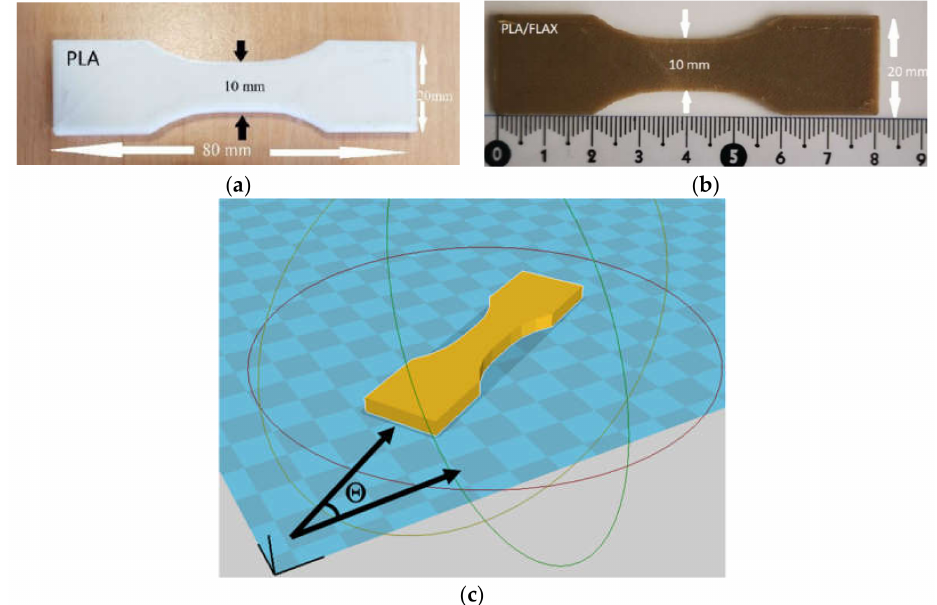
Figure 1. Dogbone geometry and related dimensions. ( a ) PLA, ( b ) PLA-flax feedstock materials, ( c ) definition of printing angle Θ